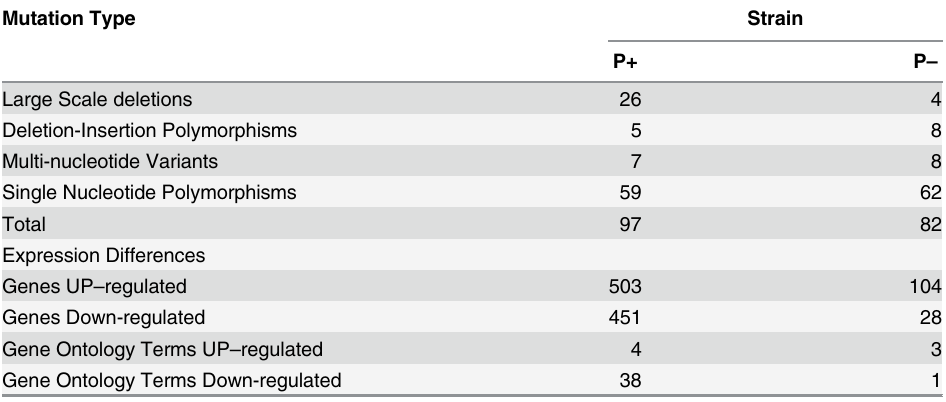
Table 1. A summary of genomic and gene expression differences between super-piliated and non- piliated Pph when compared to WT. Mutation Type